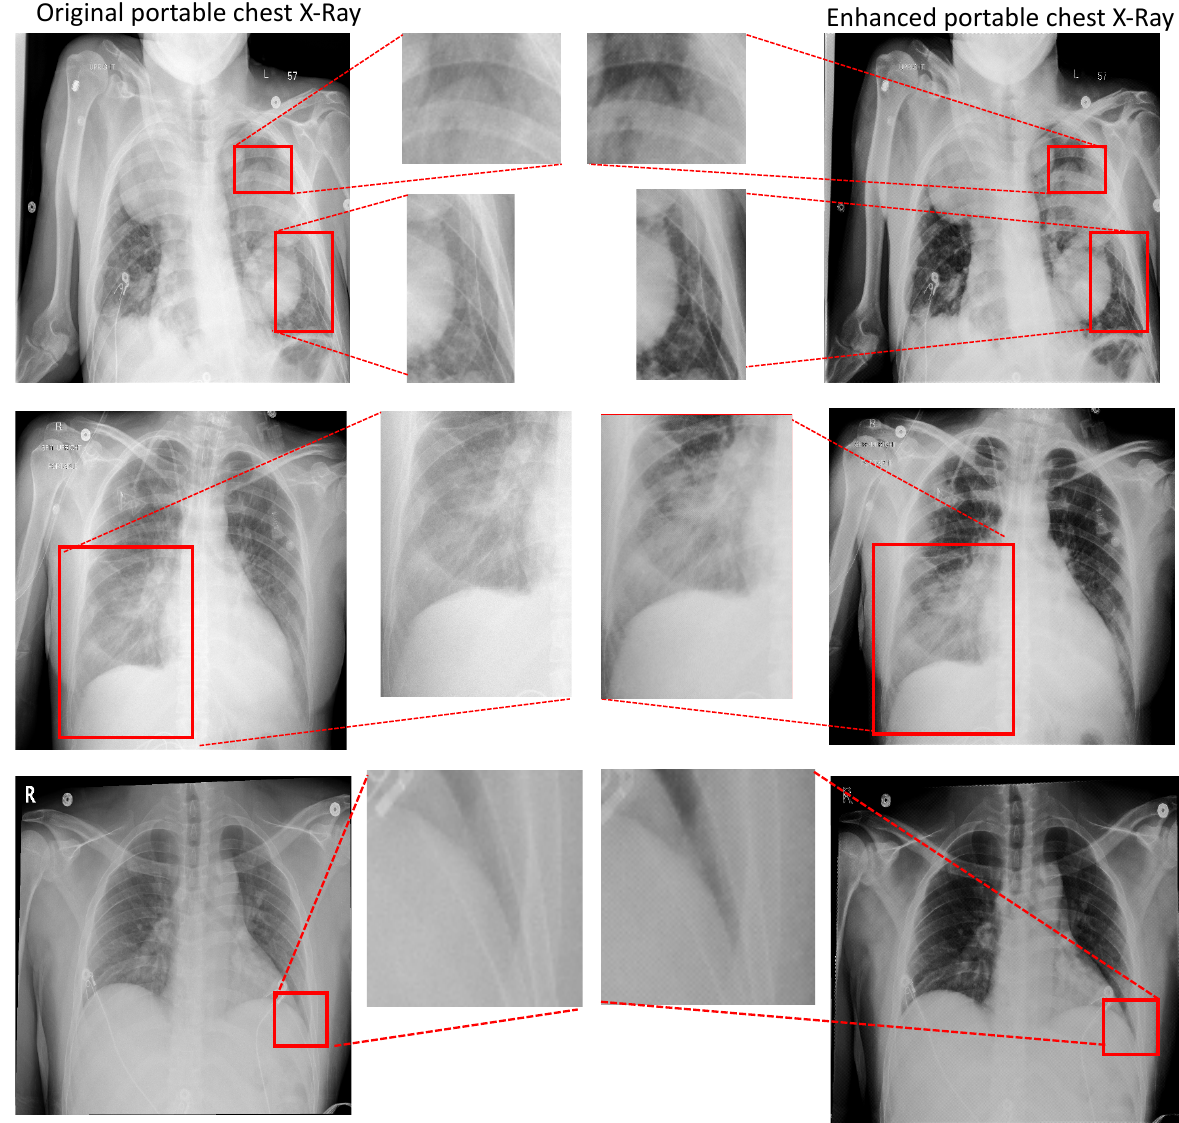
Figure 10. Illustrations of our radiograph enhancing results. From to top bottom—( Top ): our enhanced CXR (right) improves contrast between the soft-tissue masses and normal lung compared to the original portable CXR (left); ( Middle ): opacity in the right lower lobe is much more conspicuous for our enhanced CXR (right) compared to the original portable CXR (left); ( Bottom ): our enhancement algorithm is able to sharpen the angle between the ribs and diaphragm. Our enhanced result is on the right, whereas the original portable CXR is on the